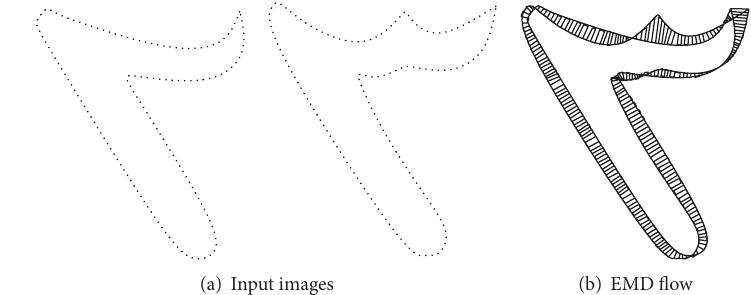
Figure 2: Computation of dissimilarity between two input images in Euclidean space and their corresponding EMD